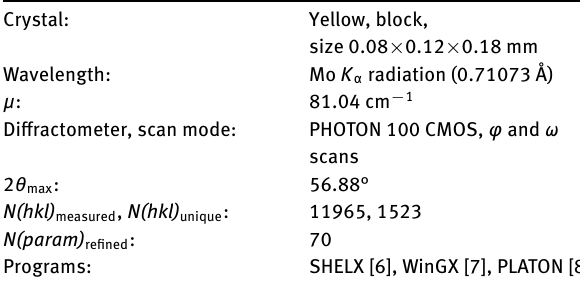
Table 2: Atomic coordinates and isotropic displacement